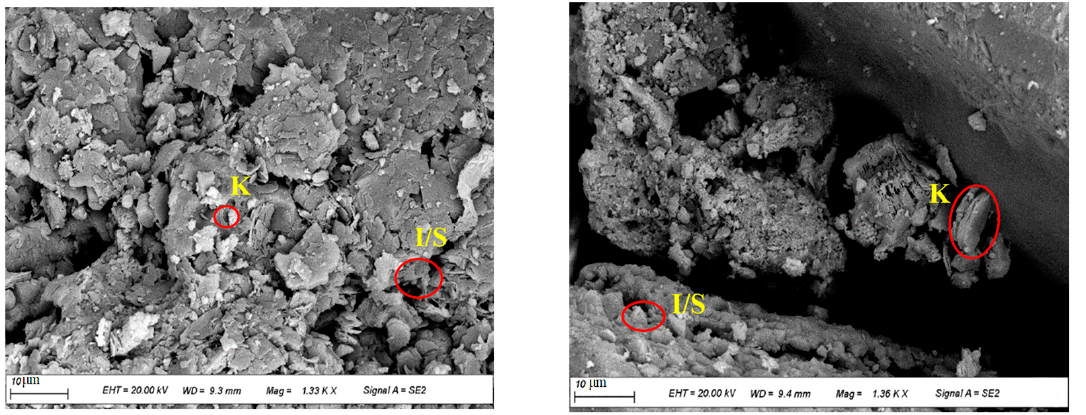
Figure 1. Mineral morphology under scanning electron microscope. Where K is for kaolinite and I/S is for illite-montmorillonite mixed layer.